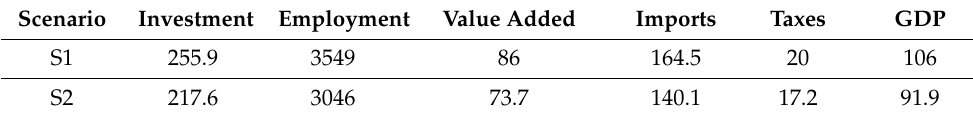
Table 3. Total absolute annual effect of investment for the period 2021–2030 (million EUR).